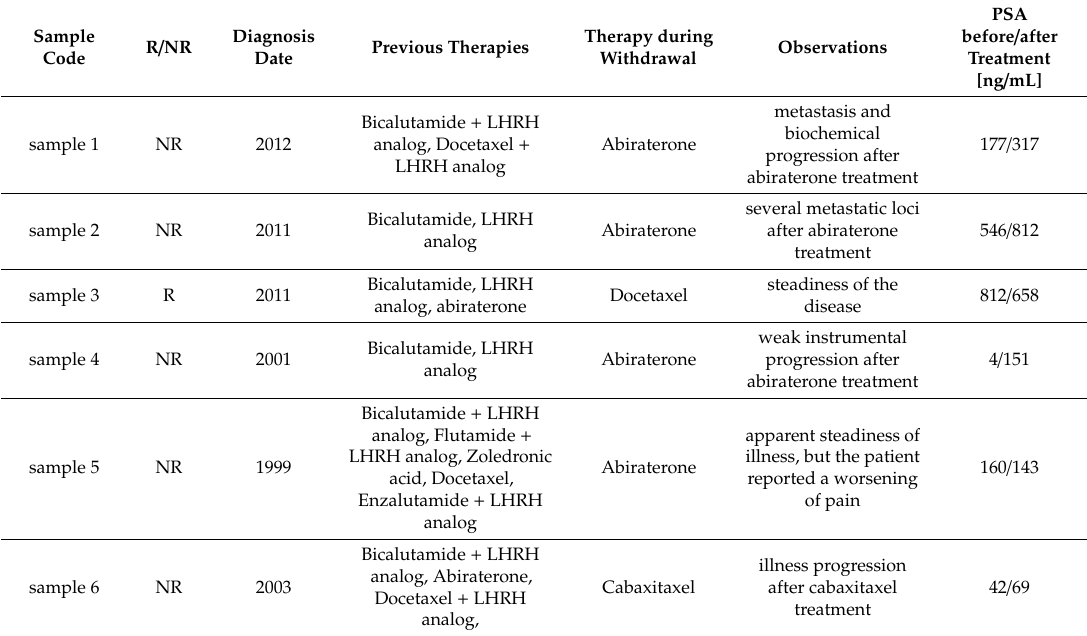
Table 1. Clinical characteristics of patients ( n = 13), Samples 2–3 and 11–12 were taken from the same two patients at di ff erent time points of treatment. Not available